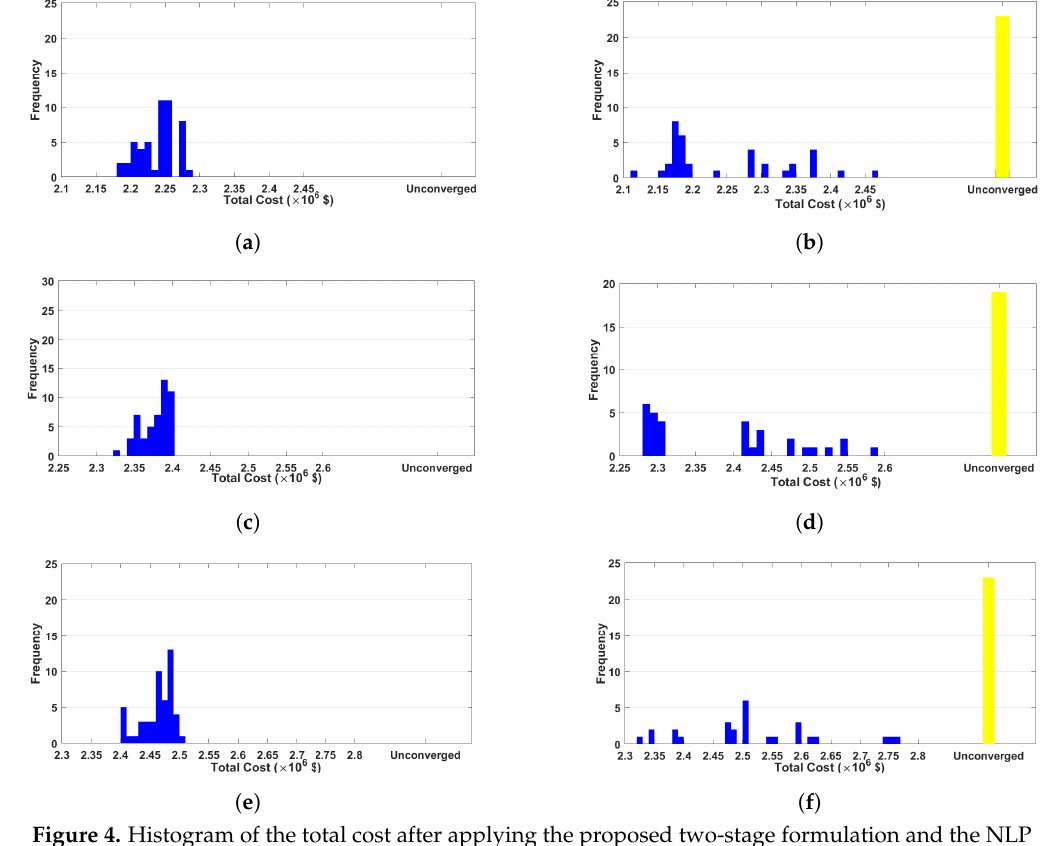
Figure 4. Histogram of the total cost after applying the proposed two-stage formulation and the NLP formulation to the two-loop network with different number of loading cases (50 runs for each of the loading cases). ( a ) Two-stage method applied to case study 1 with 4 loading conditions; ( b ) NLP method applied to case study 1 with 4 loading condition; ( c ) Two-stage method applied to case study 1 with 6 loading condition; ( d ) NLP method applied to case study 1 with 6 loading condition; ( e ) Two-stage method applied to case study 1 with 12 loading condition; ( f ) NLP method applied to case study 1 with 12 loading condition.